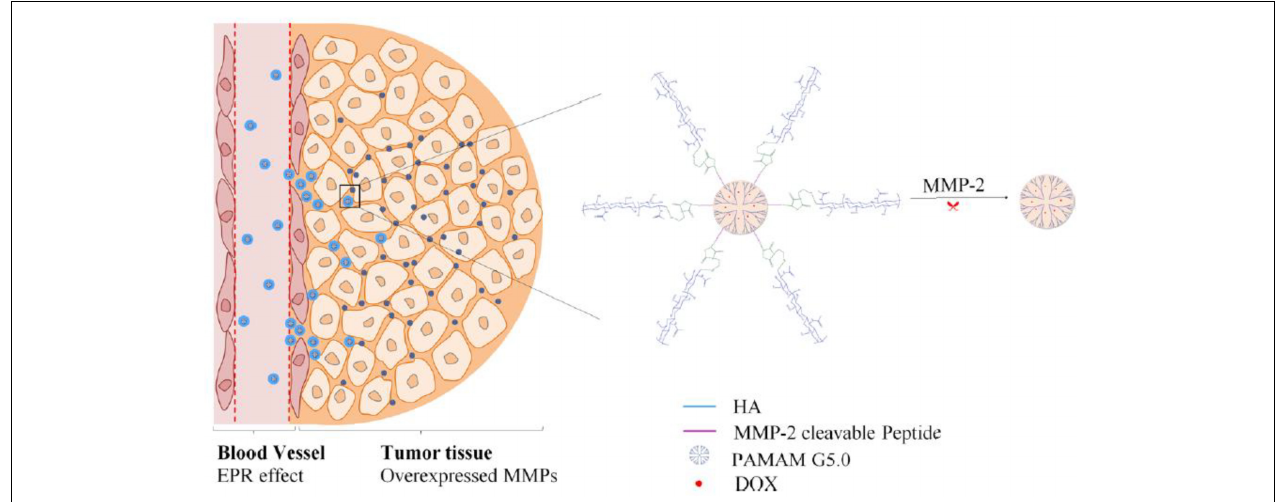
FIGURE 4 | Schematic illustration of size shrinkage of the HA-PLGLAG-PAMAM from 200 to 10 nm triggered by MMP-2, a protease highly expressed in the tumor extracellular matrix, thus achieving deep penetration into tumor and improved therapeutic efficacy (reproduced with permission from Han et al. (2017). Copyright 2017 American Chemical